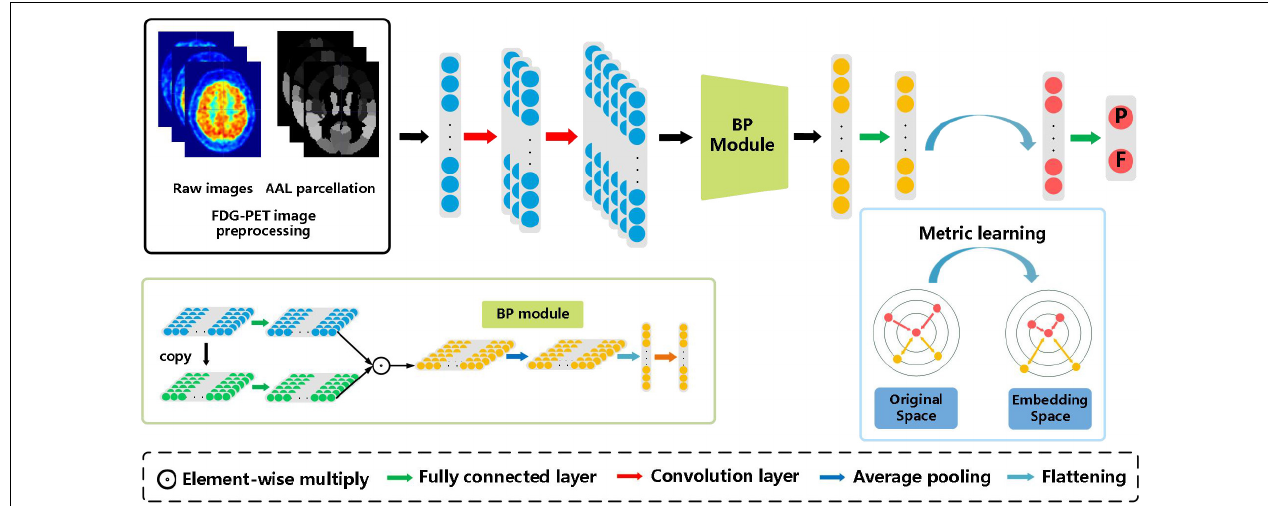
FIGURE 1 | The architecture of the proposed bilinear pooling and metric learning network (BMNet) for MCI diagnosis using PET images. There are four modules in our framework (i.e., images preprocessing module, convolutional feature-extraction module, bilinear pooling module, and the metric learning